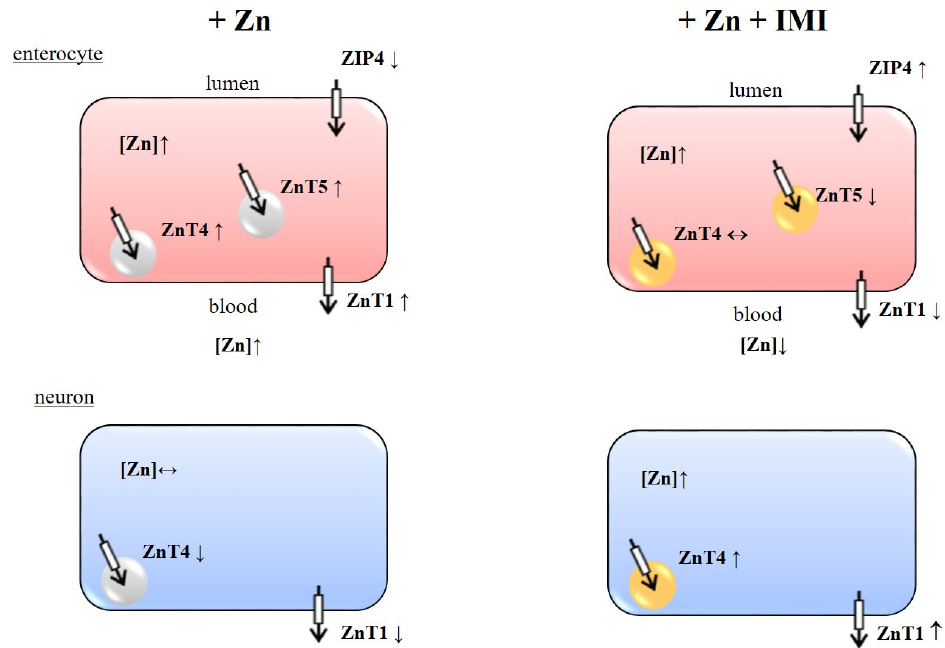
Figure 8. Schema of the effect of Zn (+ Zn) and Zn + IMI (+ Zn + IMI) treatment on zinc transporters in enterocytes and neurons. Symbols: ↑ increase, ↓ decrease, ↔ no alterations. Symbols in figures + Zn + IMI indicate alterations vs. + Zn.